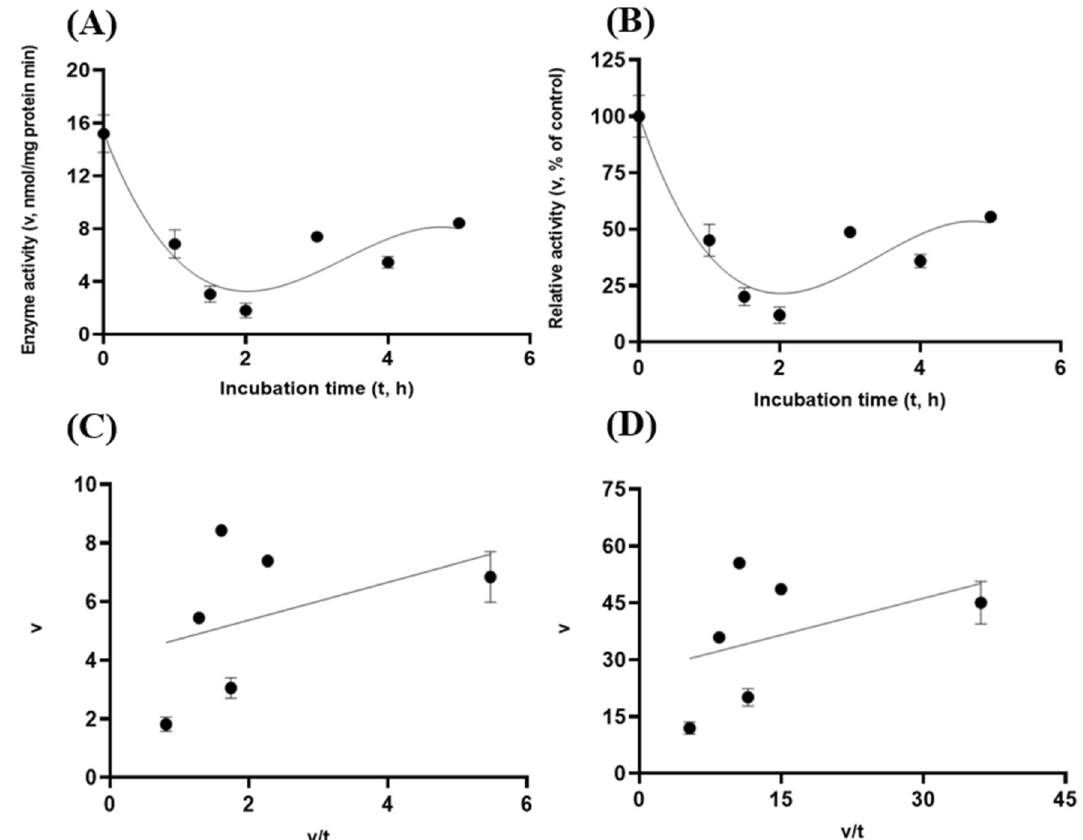
Figure 16. Experiment-3 of the intestinal pancreatic chymotrypsin (20 U/mL) effects (with describing model parameter estimates ± SE ) on heat-treated GH5-tCel5A1 activity over a 5-h period after the intestinal pancreatic chymotrypsin buffer being mixed with the heat-treated enzyme preparation for incubation at the resulting mixture pH = 6.0–7.0 and chymotrypsin (20 U/mL) prior to further incubation for measuring cellulase activity with the carboxymethyl cellulose (CMC) substrate buffer in presence of dithiothreitol (DTT) (5 mM) and N 2 gas purging for 15 min at 37 °C. (A) Plot of the inhibition kinetic relationship between the heat-treated GH5-tCel5A1 activity (v, mean ± SE, n = 12at each time point, nmol/mg protein•min) and incubation time (t, h) according to the cubic response model established as: Y = 19.238 ( ± 1.237 ) − 16.580 ( ± 1.908 ) x + 5.308 ( ± 0.829 ) x 2 − 0.487 ( ± 0.101 ) x 3 , P < 0.0001 for all parameter estimates; R 2 = 0.621 , n = 84; and alternatively according to the linear response model established as: y = 8.428 ( ± 0.994 ) − 0.618 ( ± 0.322 ) x , P < 0.0001 for the intercept; and P = 0.058 for the slope; r 2 = 0.065 , n = 84; (B) Plot of the inhibition kinetic relationship between the relative heat-treated GH5-tCel5A1 activity (v, mean ± SE, n = 12at each time point, % of the control group measured at I c of 100.000 ± 9.259) at 0-min exposure to the chymotrypsin-20-U/mL incubation) and incubation time (t, h) established according to the cubic response model as: Y = 126.7 ( ± 8.146 ) − 109.2 ( ± 12.569 ) x + 34.965 ( ± 5.458 ) x 2 − 3.210 ( ± 0.662 ) x 3 , P < 0.0001 for all the parameter estimates; R 2 = 0.622 , n = 84; and alternatively according to the linear response model as: y = 55.523 ( ± 6.547 ) − 4.072 ( ± 2.121 ) x , P < 0.0001 for the intercept; and P = 0.058 for the slope; r 2 = 0.065 , n = 84; (C ) the Eadie-Hofstee linear plot between the heat-treated GH5-tCel5A1 enzyme activity (v, mean ± SE, n = 12at each data point, nmol/mg protein•min) and the v/t ratio established as: y = 3.337 ( ± 0.424 ) + 0.998 ( ± 0.142 ) x , P < 00001 for all parameter estimates, r 2 = 0.421 , n = 72; and (D ) the Eadie-Hofstee linear plot between the relative heat-treated GH5-tCel5A1 enzyme activity (v, mean ± SE, n = 12at each data point, % of the control group measured at I c of 100.000 ± 9.259) at 0-min exposure to the chymotrypsin-20-U/mL incubation) and the v/t ratio established as: y = 21.988 ( ± 2.793 ) + 0.998 ( ± 0.142 ) x , P < 0.0001 for all parameter estimates, r 2 = 0.421, n =